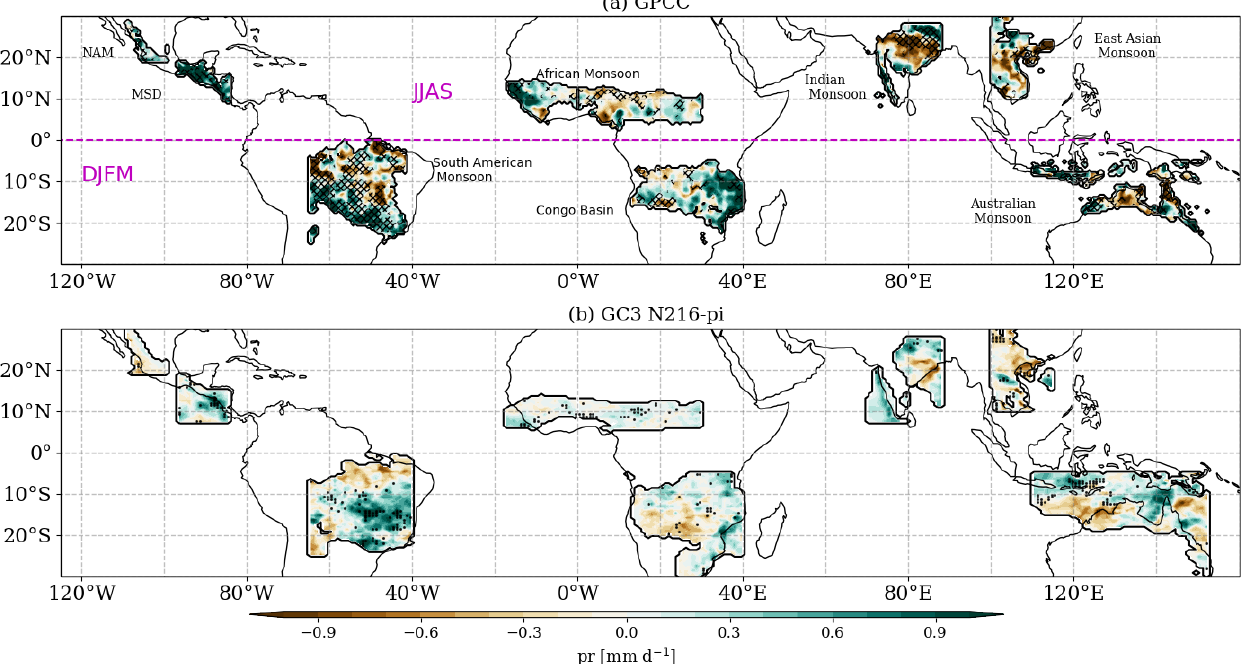
Figure 10. Total precipitation differences in monsoon regions between QBO W–E phases under ENSO-neutral conditions only for (a) GPCC (1953–2020) using the FUB QBO index and (b) GC3 N216-pi. For monsoon regions in the Northern Hemisphere, differences are shown for the JJAS period, whereas for Southern Hemisphere monsoons, results are shown for DJFM. Hatching and dots indicate differences that are statistically significant to the 95% level. NAM and MSD stand for the North American monsoon and the Midsummer Drought (García-Franco et al., 2020),